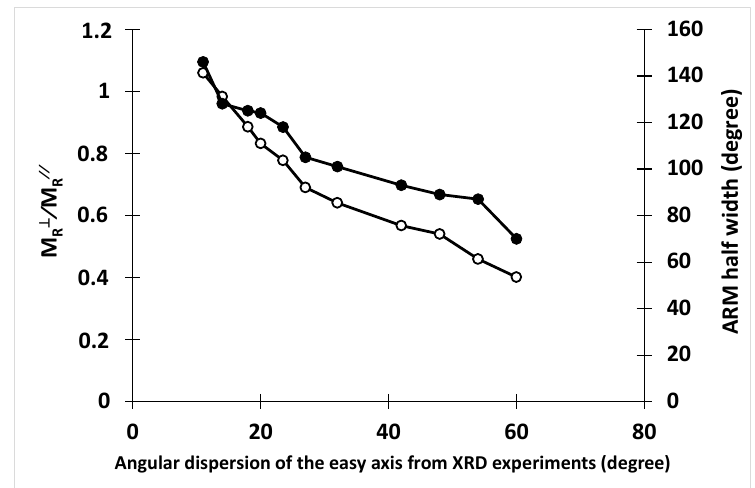
Figure 15 . Correlation between 2 θ , M R ⊥ ⁄ M R ∕∕ (open symbols) and ARM (full symbols). Figure 15. Correlation between 2 θ , M R ⊥ ⁄ M R ⁄⁄ (open symbols) and ARM (full symbols).